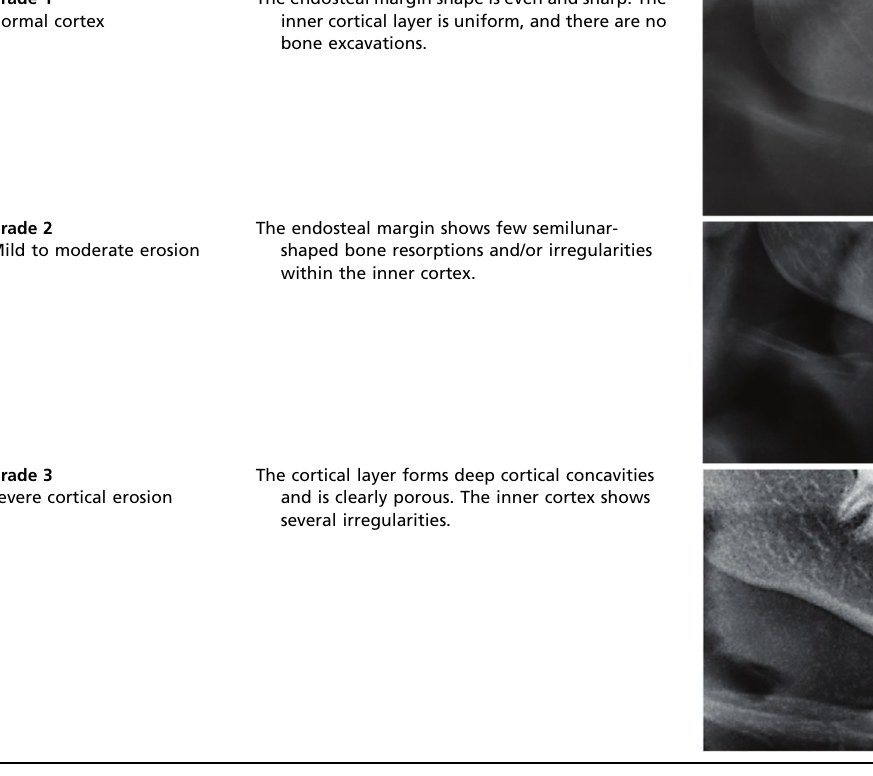
Table 1 - Klemetti index categories for panoramic radiographs. Grade 1 Normal cortex